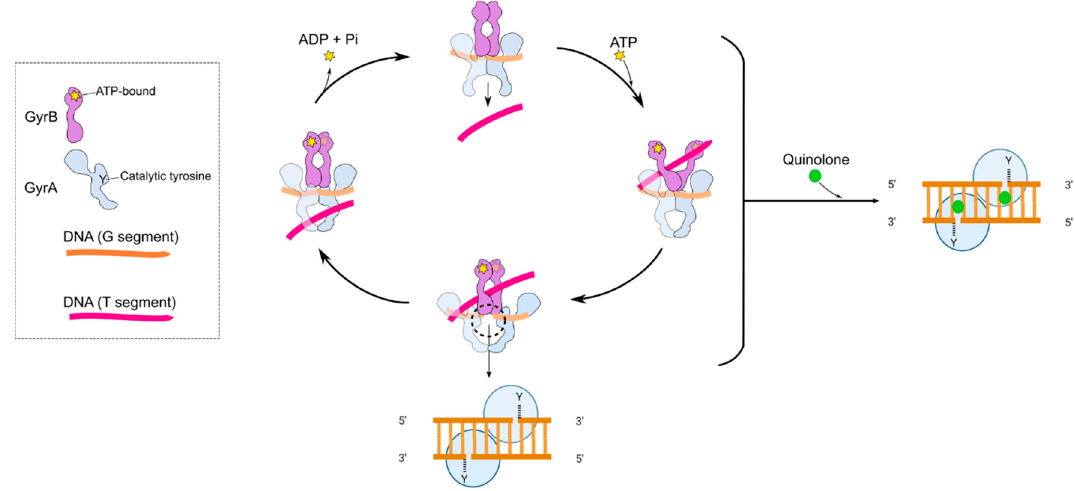
Figure 4. Cartoon showing the proposed mechanism of DNA supercoiling by DNA gyrase and how quinolones interfere with this mechanism by stabilising the cleavage complex. The inset shows the GyrA (blue) and GyrB (purple) subunits. Y indicates the position of the active site tyrosine, and the star indicates the position of the ATP-binding site. The G segment (orange) binds across the GyrA dimer interface. The GyrA C-terminal domain wraps the DNA (not shown) to present the T segment (pink) in a positive node. ATP binds to the N-terminal domain of GyrB, which closes the GyrB clamp (also known as the N-gate), capturing the T segment. The G segment is transiently cleaved, the GyrB domains rotate (not shown), the DNA gate widens and the T segment is transported through the cleaved G segment. The G segment is re-ligated, and the T segment exits through the GyrA C-gate. The hydrolysis of ATP and the leaving of ADP + Pi resets the enzyme for another cycle, although the exact timing of these reactions is unknown. The black-dashed circle and lower inset show the cleavage complex. The right-hand panel shows the binding of quinolones (green spheres) in the cleavage complex.